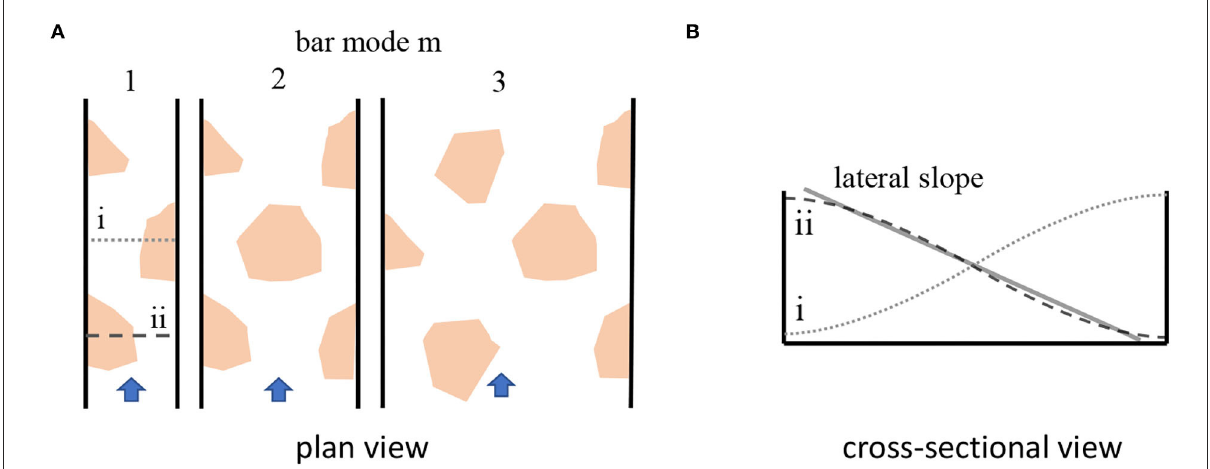
FIGURE1 Sketch of alternate bars with different mode in plan view (A) and cross-sectional profile of single row alternate bars and definition of the lateral bed slope (B) .